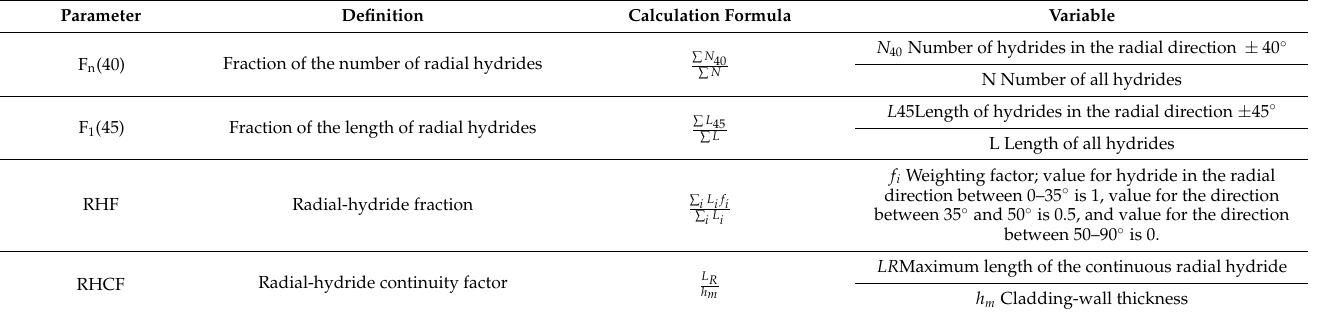
Table 2. Various parameters proposed to quantify the degree of hydride reorientation [96]. Reprinted with permission from [96]; Copyright 2018